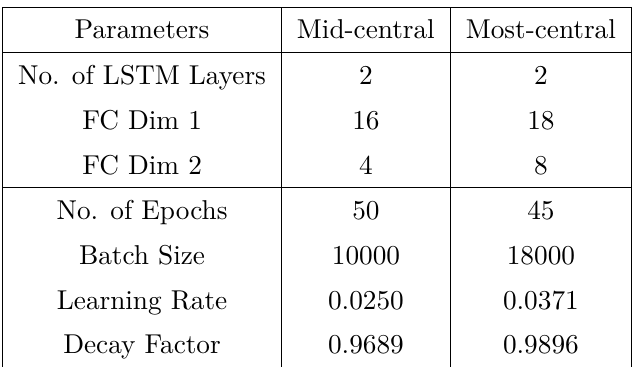
Figure 8 . Distribution of validation loss for different architecture configurations, for the mid- central event mixing (left) and the most-central event mixing (right) respectively. The best models are indicated in red dots. The outer probability density contours cut off at the min/max values of the validation loss. The inner white point represents the median value. The inner thick bar spans the first and the third quartiles of the distributions.